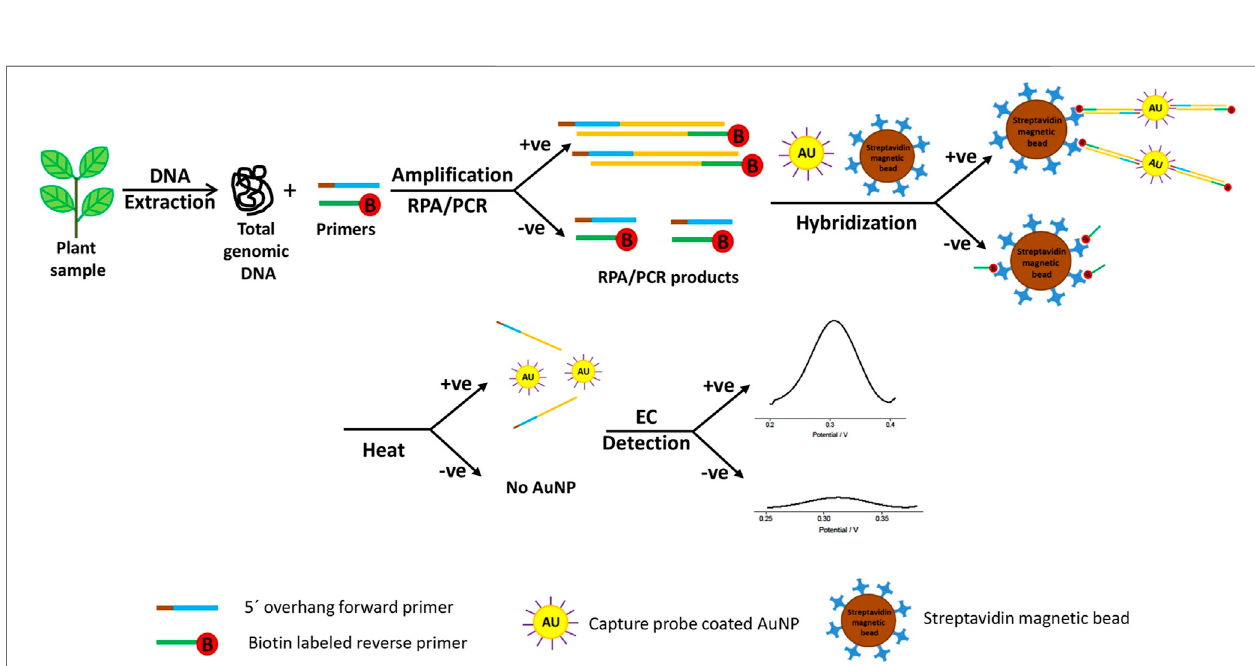
FIGURE 2 | Schematic exemplum of the DNA-based electrochemical bioassay for plant pathogen detection. Adapted with permission from Lau et al. (Lau et al., 2017). EC stands for electrochemical detection and AuNP for gold nanoparticles.